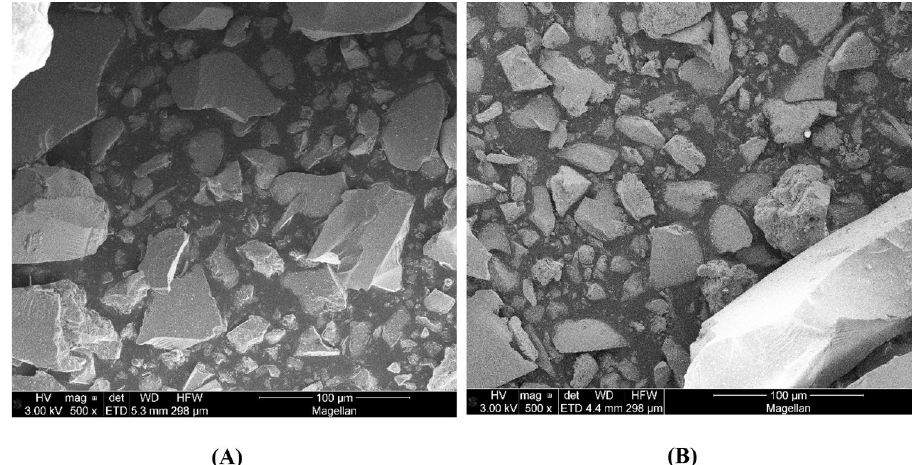
Figure 4. Scanning Electron Microscopy (SEM) micrograph of SiTiNb-A (A) and SiTiNb-B (B) materials.